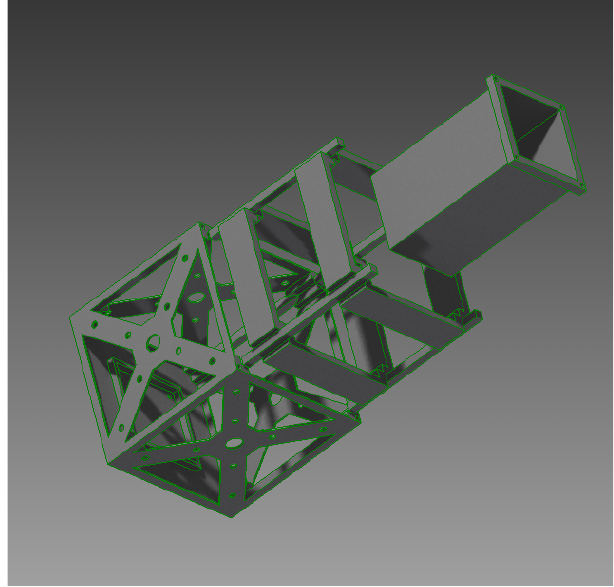
Figure 10. Exploded View of Computer Board and Payload Support